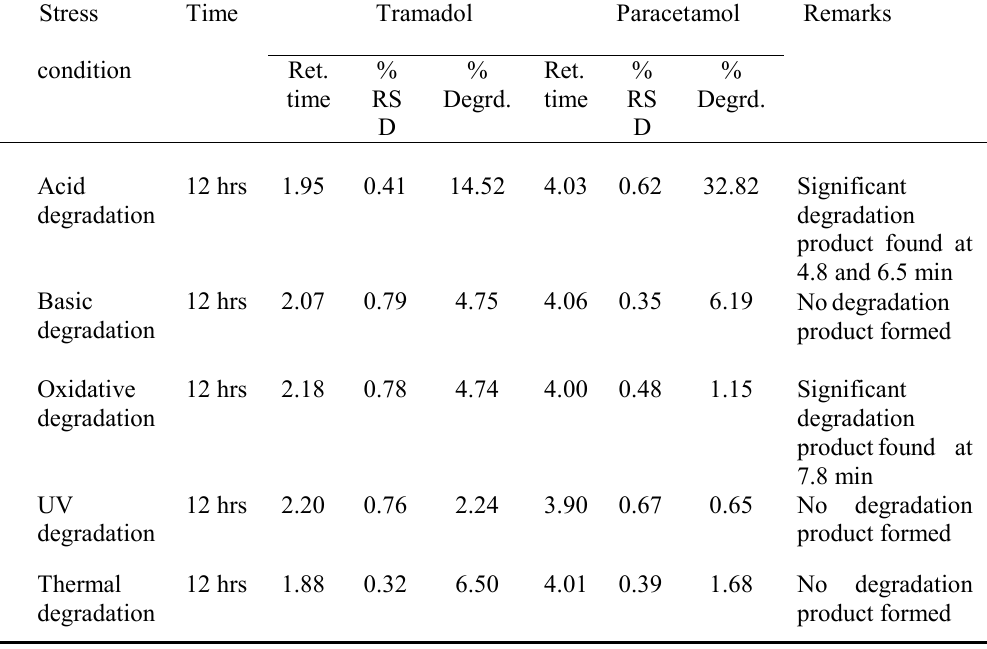
Table 1. Results from analysis of samples from the forced degradation